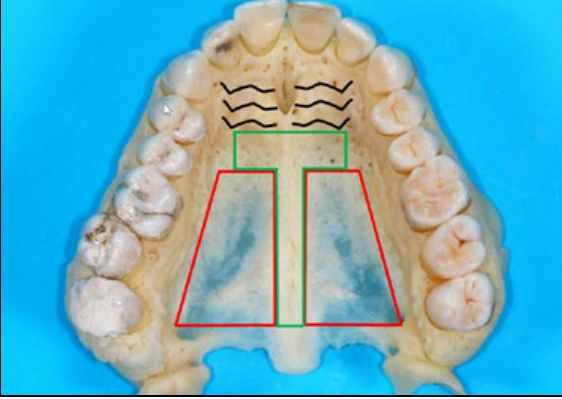
Figure 1. ‘Mini-Mousetrap’ appliance design and mechanics: A lever arm is connected to a palatal plate, anchored by two mini-implants in the anterior palate. The centre of resistance of the molar should be considered three-dimensionally to avoid unwanted tooth movement.